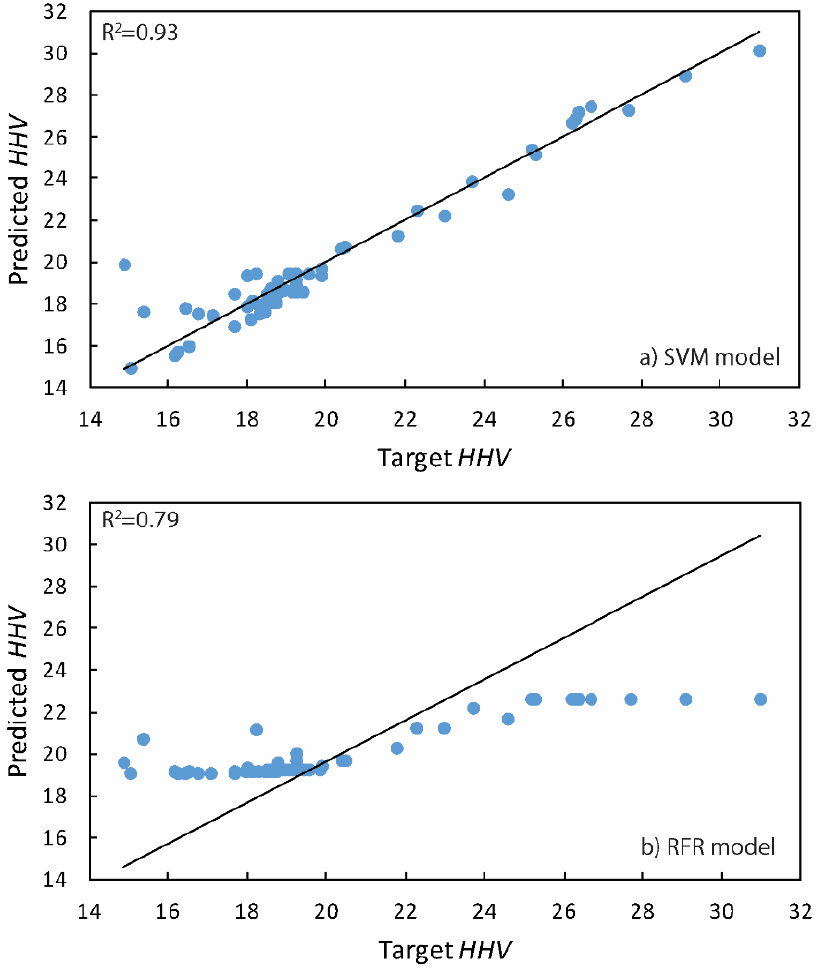
Figure 4. Parity plot of predicted HHV vs. Target HHV for developed ( a ) SVM and ( b ) RFR mod- els